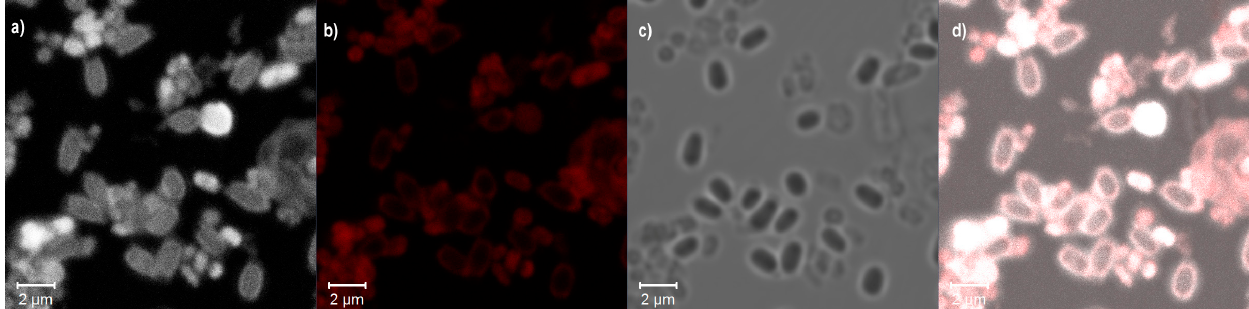
Figure 9. Fluorescence and light microscopy images of: ( a ) S. epidermidis cells on a surface; ( b ) MIP nanoparticles on the surface; ( c ) transmitted light image of cells plus nanoparticles; ( d ) overlay of transmitted light image and fluorescence data.